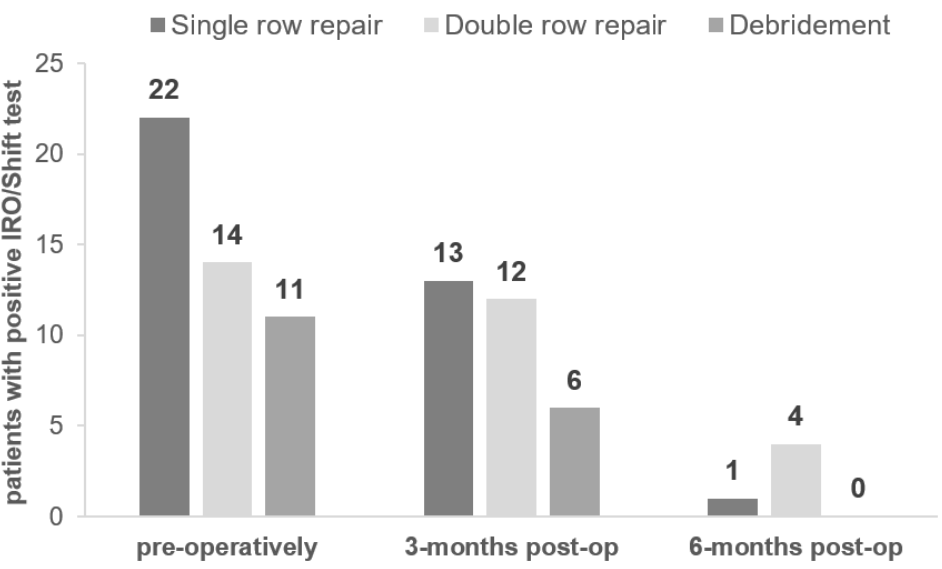
Figure 2. Number of positive IRO/Shift tests longitudinally based on surgical procedure ( n = 51). Among the 36 patients who underwent arthroscopic surgery, but did not have a rotator cuff tear, 15 had a positive IRO/Shift test and 8 had a positive Jobe test pre-surgery. At 3 months post-surgery there were six positive IRO/Shift and six positive Jobe tests, while at 6 months there was only one positive IRO/Shift and two positive Jobe tests. In total, 47 of the 51 surgical patients presented with a positive IRO/Shift test pre- surgery, while 48 presented with a positive Jobe test (Figure 3). At 3 months post-surgery there were 31 positive IRO/Shift tests and 36 positive Jobe tests. Meaning only 39% (20/51) had a negative IRO/Shift test and 29% (15/51) had a negative Jobe test at 3 months post- surgery. However, at 6 months post-surgery there were only 5 remaining positive IRO/Shift tests and 18 positive Jobe tests. This resulted in 90% of the patients (46/51) presenting with a negative IRO/Shift test and 65% (33/51) of the patients presenting with a negative Jobe test at 6 months post-surgery. When compared to each other over time, the observed accuracy between the tests decreased. The IRO/Shift test and Jobe test had 90% agreement (i.e., accuracy) pre-operatively, 71% agreement at 3 months post-surgery, and 67% agree- ment at 6 months (Table 2).